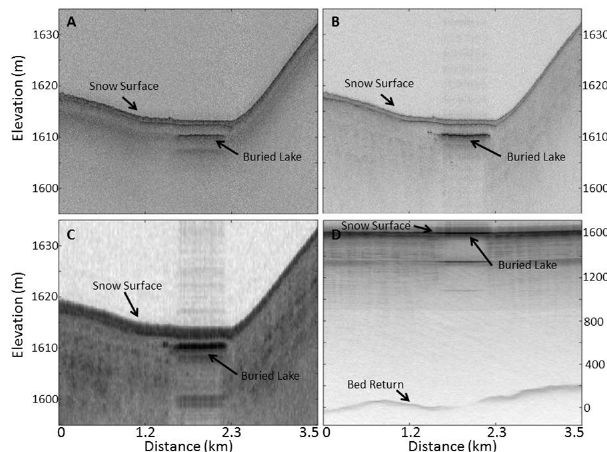
Figure 2. Radar echograms from western Greenland ( ∼ 90km in- land of Jakobshavn’s terminus) showing radar signal attenuation at multiple frequencies over a buried lake from the (a) Ku-band Radar ( ∼ 13–17GHz), (b) Snow Radar ( ∼ 2–6.5GHz), (c) Accumula- tion Radar ( ∼ 600–900MHz) and (d) MCoRDS Radar ( ∼ 140–